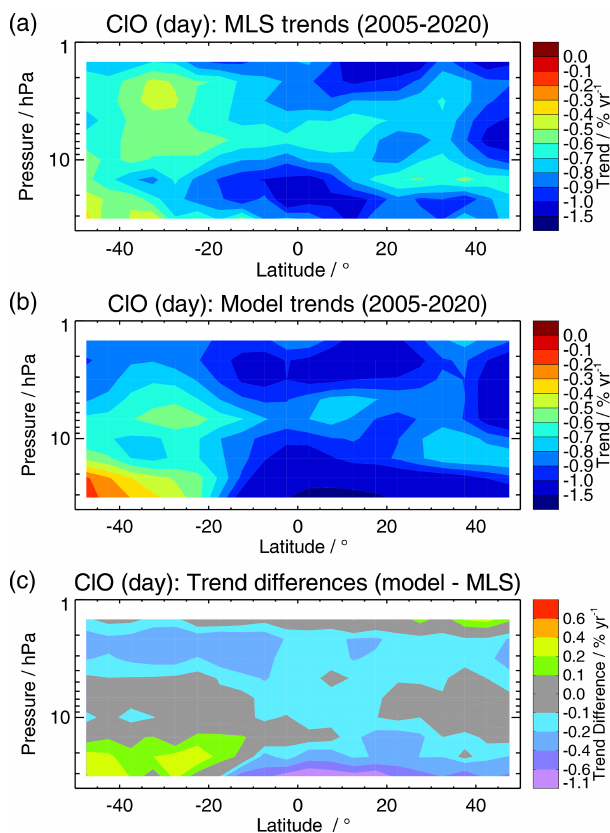
Figure 4. Contour plots of ClO (day) trends (%yr − 1 ) for the pe- riod 2005 through 2020 from (a) MLS and (b) model, with panel (c) showing the differences (%yr − 1 ) in these trends (model – MLS).